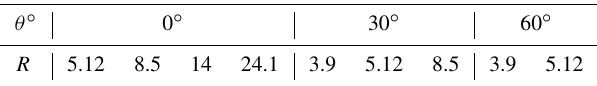
Table 1. Location of the nine waves gauges referenced to the toe’s slope.